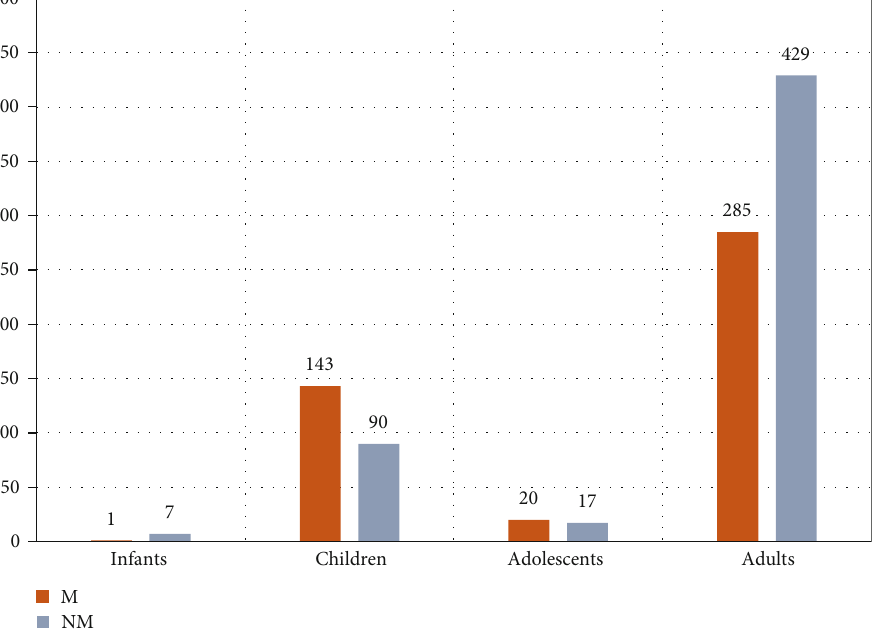
Figure 1: Distribution and proportions of malignant and nonmalignant primary CNS tumors in di ff erent age groups.